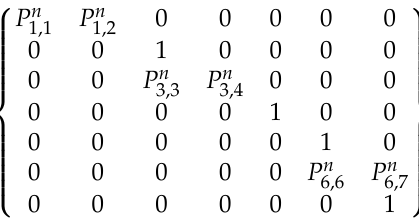
Figure 5. Example transition matrix P n with three operations of duration 2, 3 and 1, which results in 7 states: The first operation with one helper state, the second operation with two helper states, the third operation with no helper state and the final